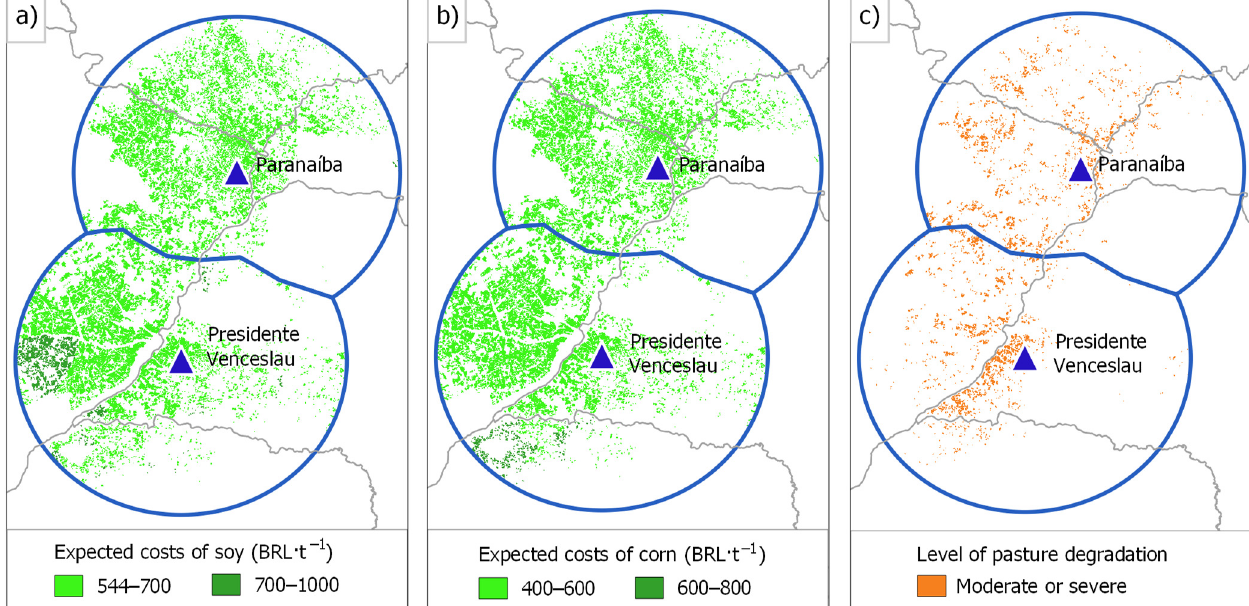
Figure 7. Expected costs of ( a ) soybean and ( b ) corn production in available areas for agriculture expansion, in clusters of 100 ha, considering transport costs from the field to the feedstock processing units (triangles); ( c ) Available areas for agriculture expansion only in pasturelands with moderate and severe degradation.